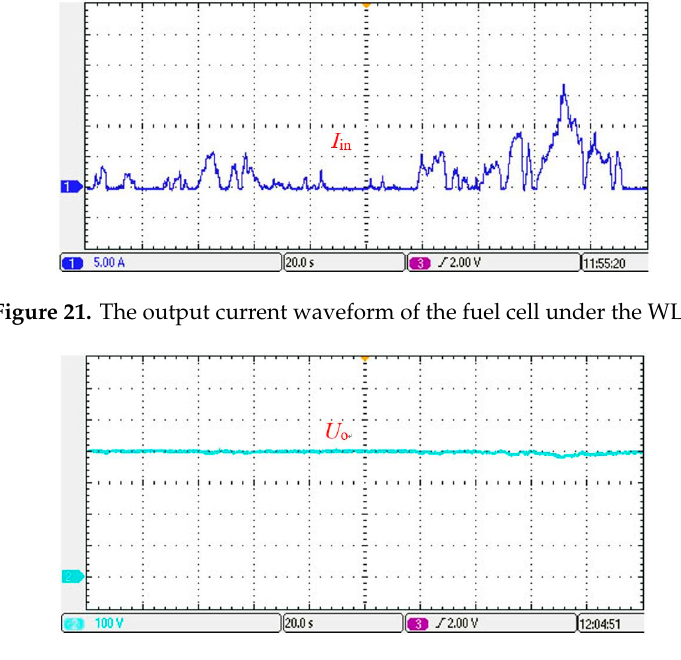
Figure 22. The converter output voltage waveform under the WLTP.